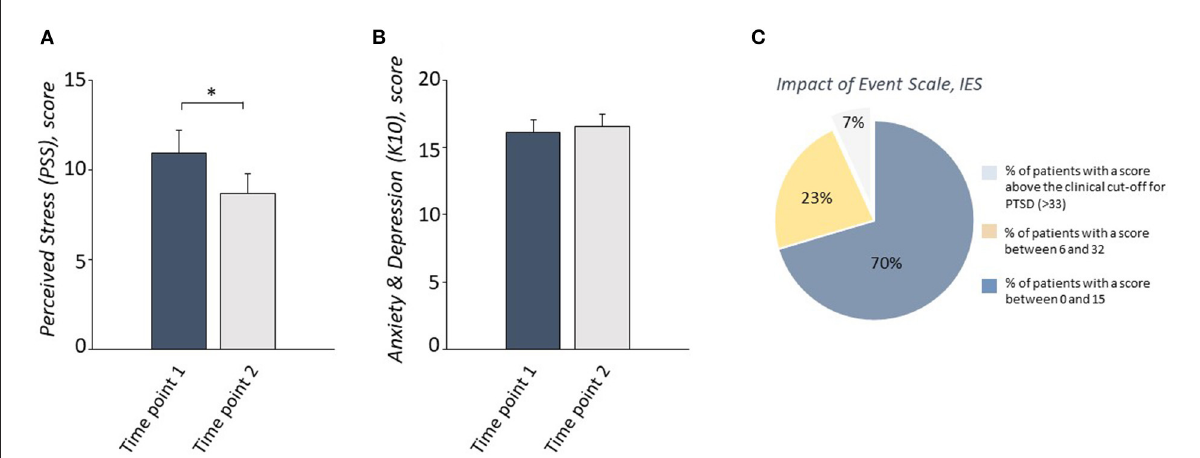
FIGURE2 A reduction of the perceived stress levels (A) , but no change in anxious-depressive symptoms (B) , measured respectively by PSS and K10, was observed in COVID-19 patients between Time point 1 and Time point 2. 70% of patients obtained a score between 0 and 15, 23% obtained a score between 16 and 32, and only 7% of patients scored above the clinical cut-off for PTSD symptoms measured by IES-R at Timepoint 2 (C) . * P < 0.05.